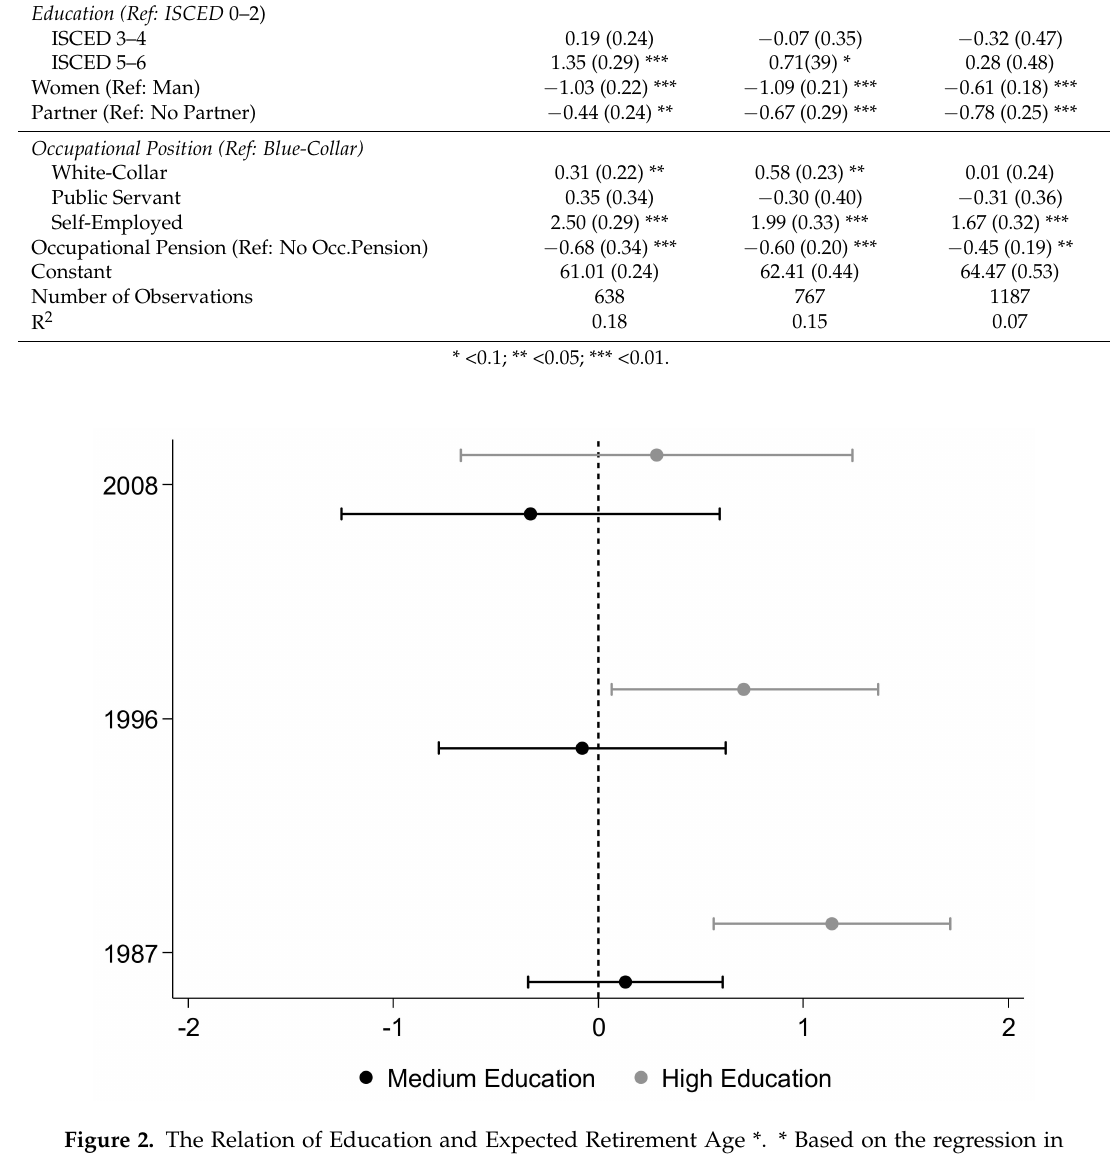
Figure 2. The Relation of Education and Expected Retirement Age *. * Based on the regression in Table 1. Reference category is Low Education (ISCED 0–2). The relationship is statistically significant when the 90% confidence interval (gray and black vertical lines) does not overlap the dotted